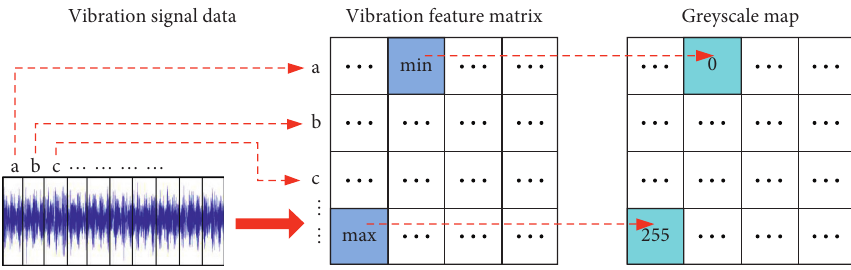
Figure 8: Mapping relationship of grayscale